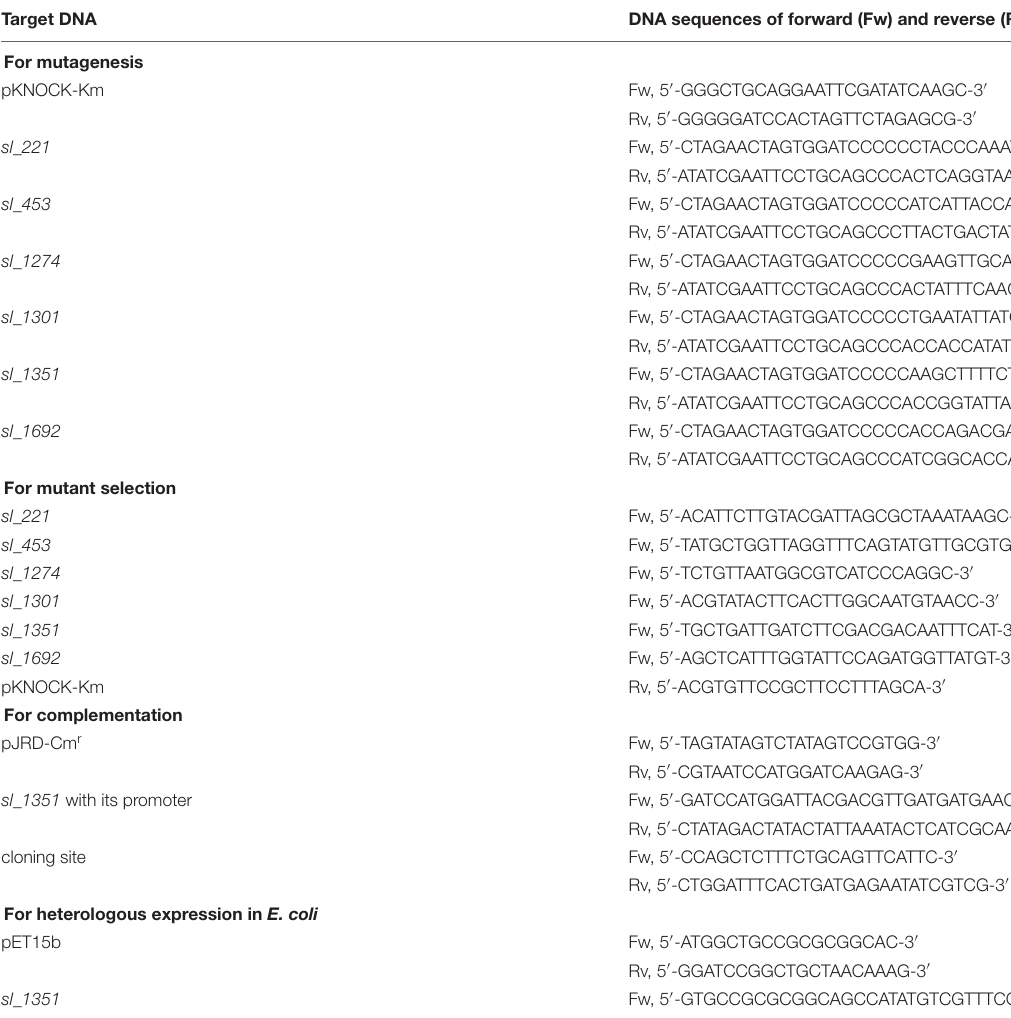
TABLE 1 | Primers used in this